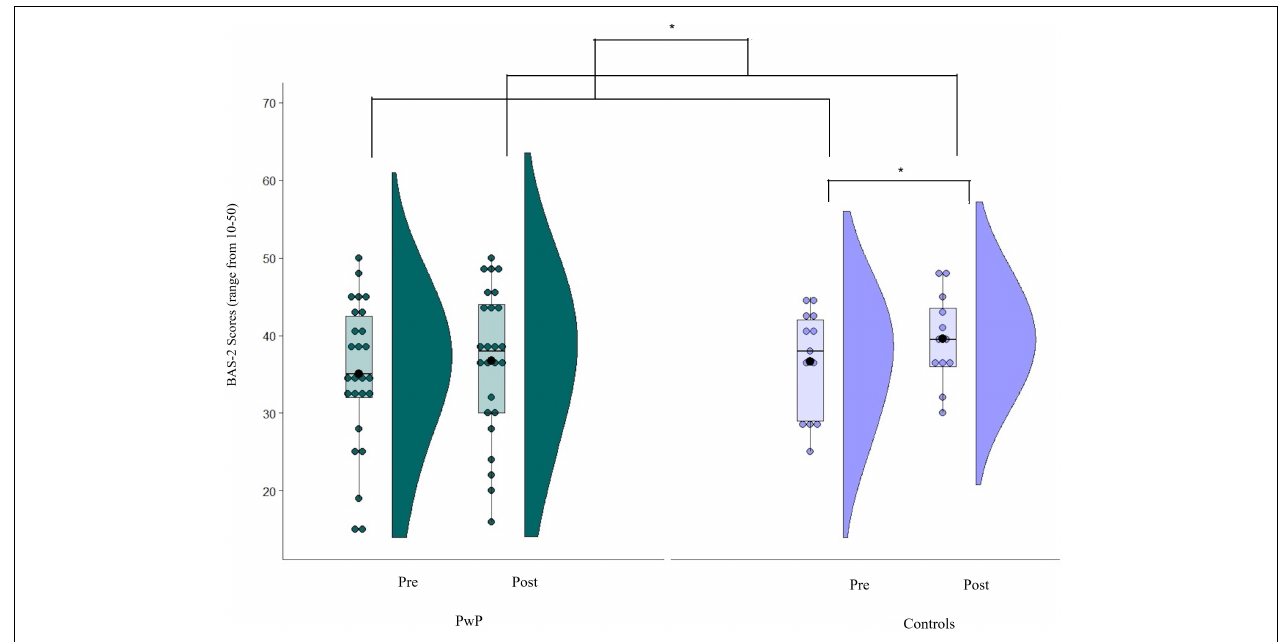
FIGURE 4 | Mean values of the body appreciation (BAS-2). Scores on a scale from 10 (lower body appreciation) to 50 (greater body appreciation); Solid line = median; Black dot = mean; Whiskers: upper whisker = min(max(x), Q_3 + 1.5*IQR); lower whisker = max(min(x),